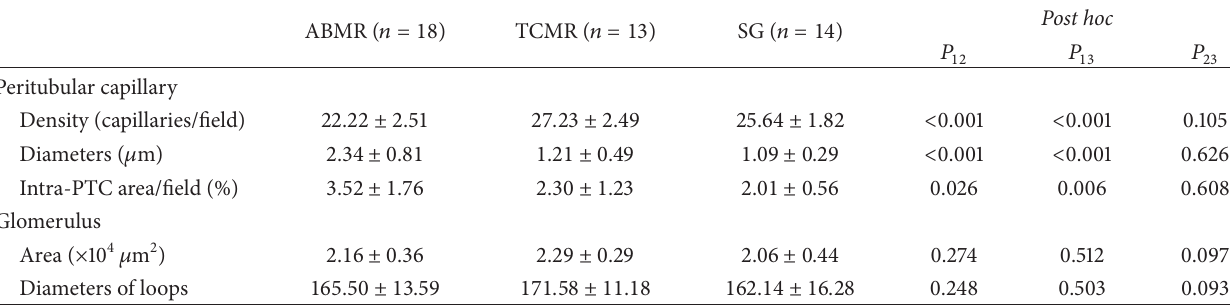
Table 4: Capillary variation in different groups.